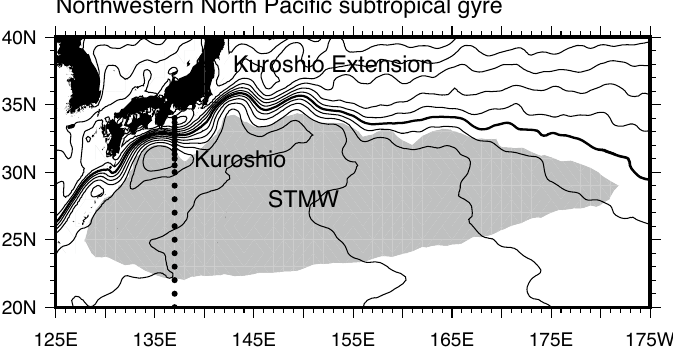
Figure 1. The Kuroshio and STMW in the northwestern North Pacific subtropical gyre. Contours represent mean sea surface height (cm) during 1993–2020 (10-cm intervals) (see text for details of the dataset). The 100-cm contour (thick line) is located near the Kuroshio axis south of Japan. The distribution region of STMW is schematically illustrated with gray shading based on Oka and Qiu 3 . Dots indicate the grid points of the optimally interpolated gridded dataset of the repeat hydrographic section along 137°E by the Japan Meteorological Agency (see text for